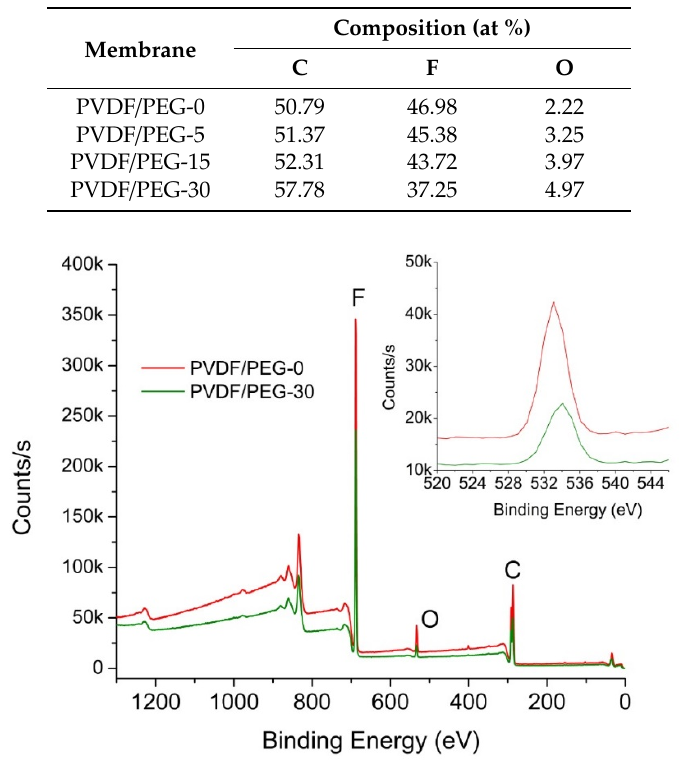
Figure 7 . XPS wide scan spectra of PVDF/PEG-0 and PVDF/PEG-30 membranes (inset shows the Figure 7. XPS wide scan spectra of PVDF / PEG-0 and PVDF / PEG-30 membranes (inset shows the corresponding intensity of selected element). corresponding intensity of selected